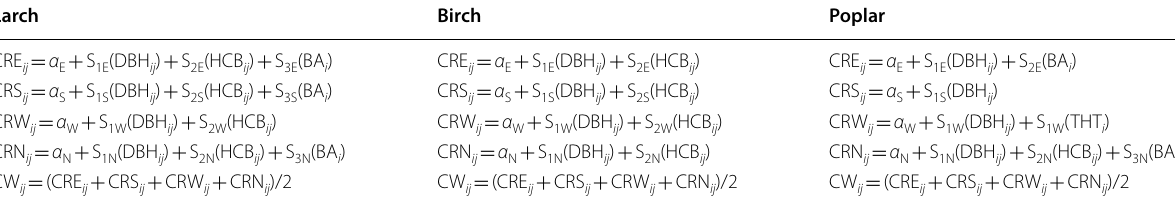
Note : α E , α S , α W , and α N are intercepts of the four CR; S 1